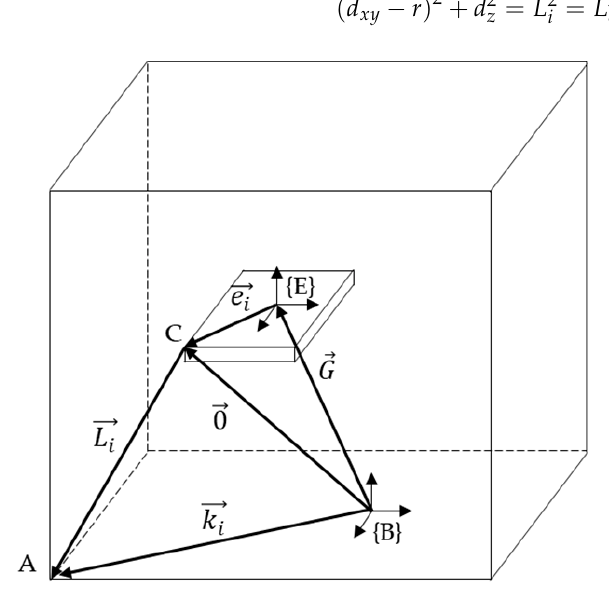
Figure 2. Diagrammatic representation of the kinematic parameter.